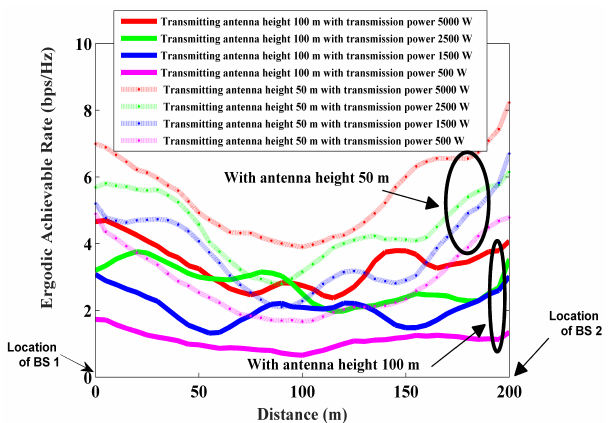
Figure 16. Estimated ergodic achievable rate along a profile of length 200 m connecting the two transmitting BSs of varying antenna height and transmission power.